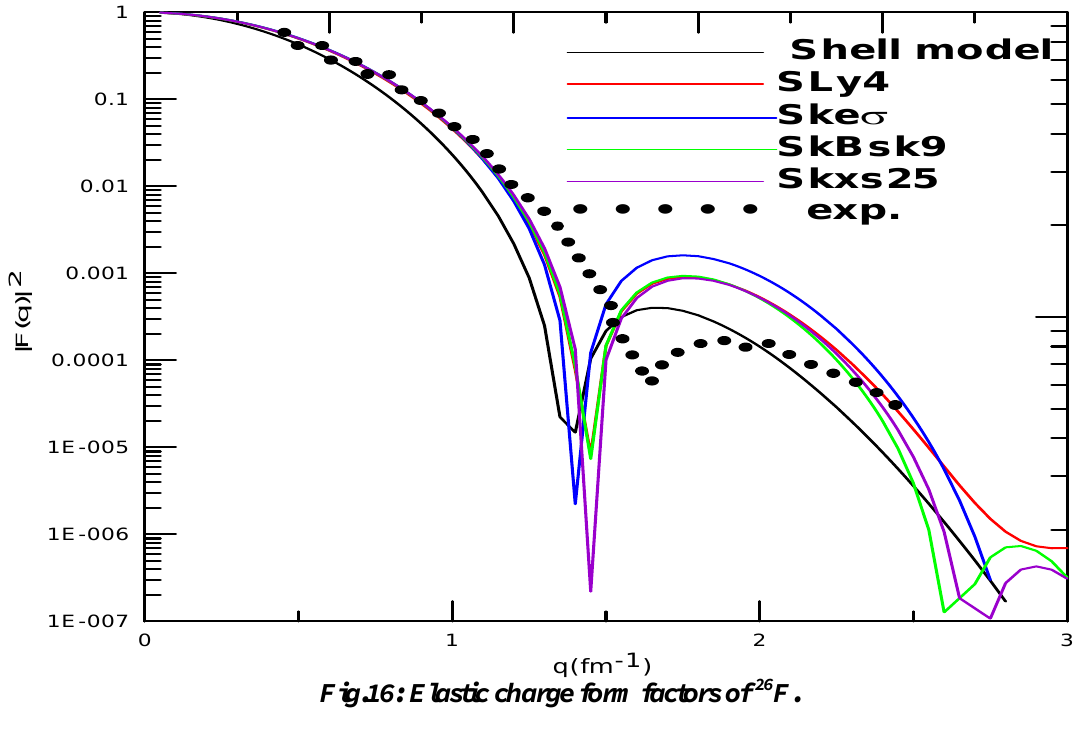
Fig.16: Elastic charge form factors of 26